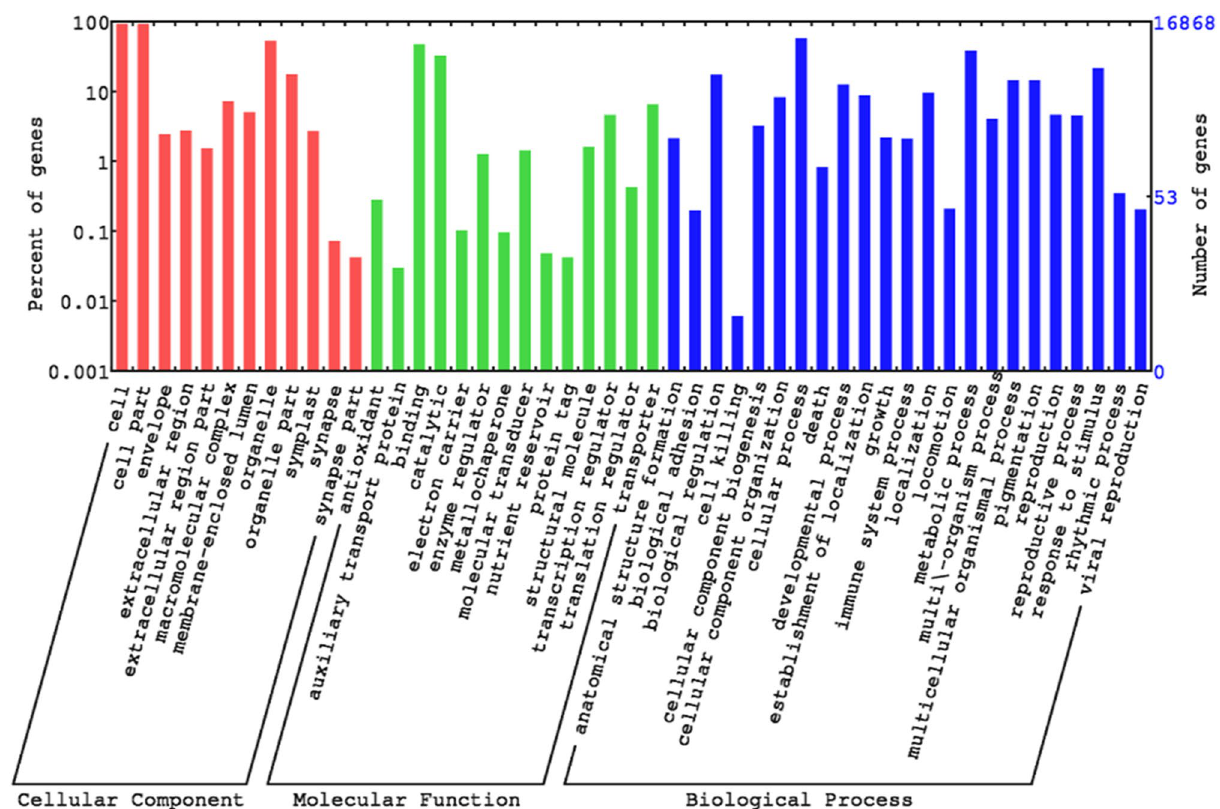
Figure 2. Functional classification of unigenes by Web Gene Ontology (WEGO). A total of 16,868 unigenes were annotated with the WEGO database for cellular component, molecular function, and biological process categories. X-axis indicates GO category and y-axis indicates the percent of